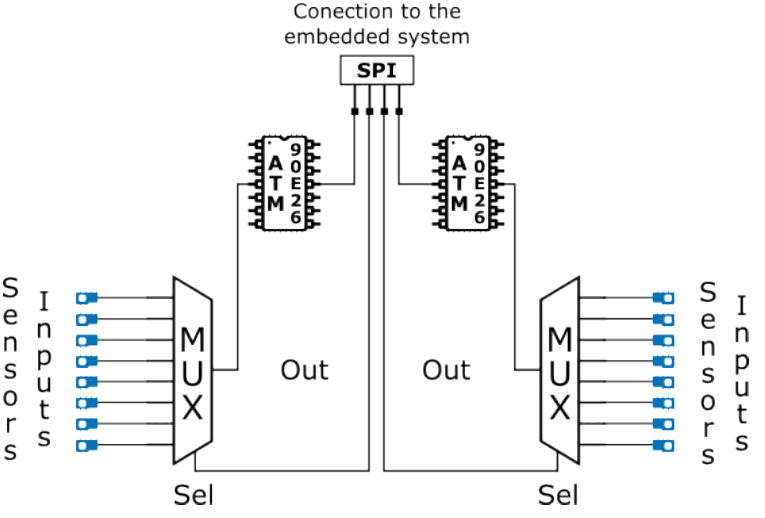
Figure 7. PCB Sensors Interface